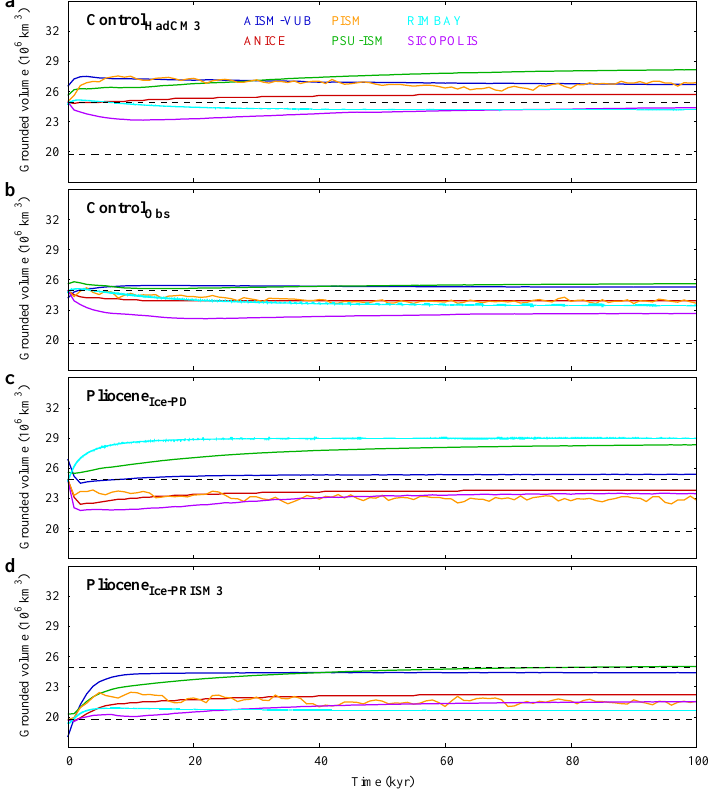
Figure 2. Modelled grounded ice volume over 100kyr with Bedmap1. (a) The Control HadCM3 simulation, with HadCM3 pre-industrial climate forcing. (b) The Control Obs simulation, with ERA-40/WOD09 climate forcing. (c) The Pliocene Ice-PD simulation, with HadCM3 Pliocene climate forcing and an initial PD ice sheet. (d) The Pliocene Ice-PRISM3 simulation, with HadCM3 Pliocene climate forcing and the initial PRISM3 ice sheet. The horizontal dashed lines indicate the PD and Pliocene grounded ice volume of the Bedmap1 ice-sheet